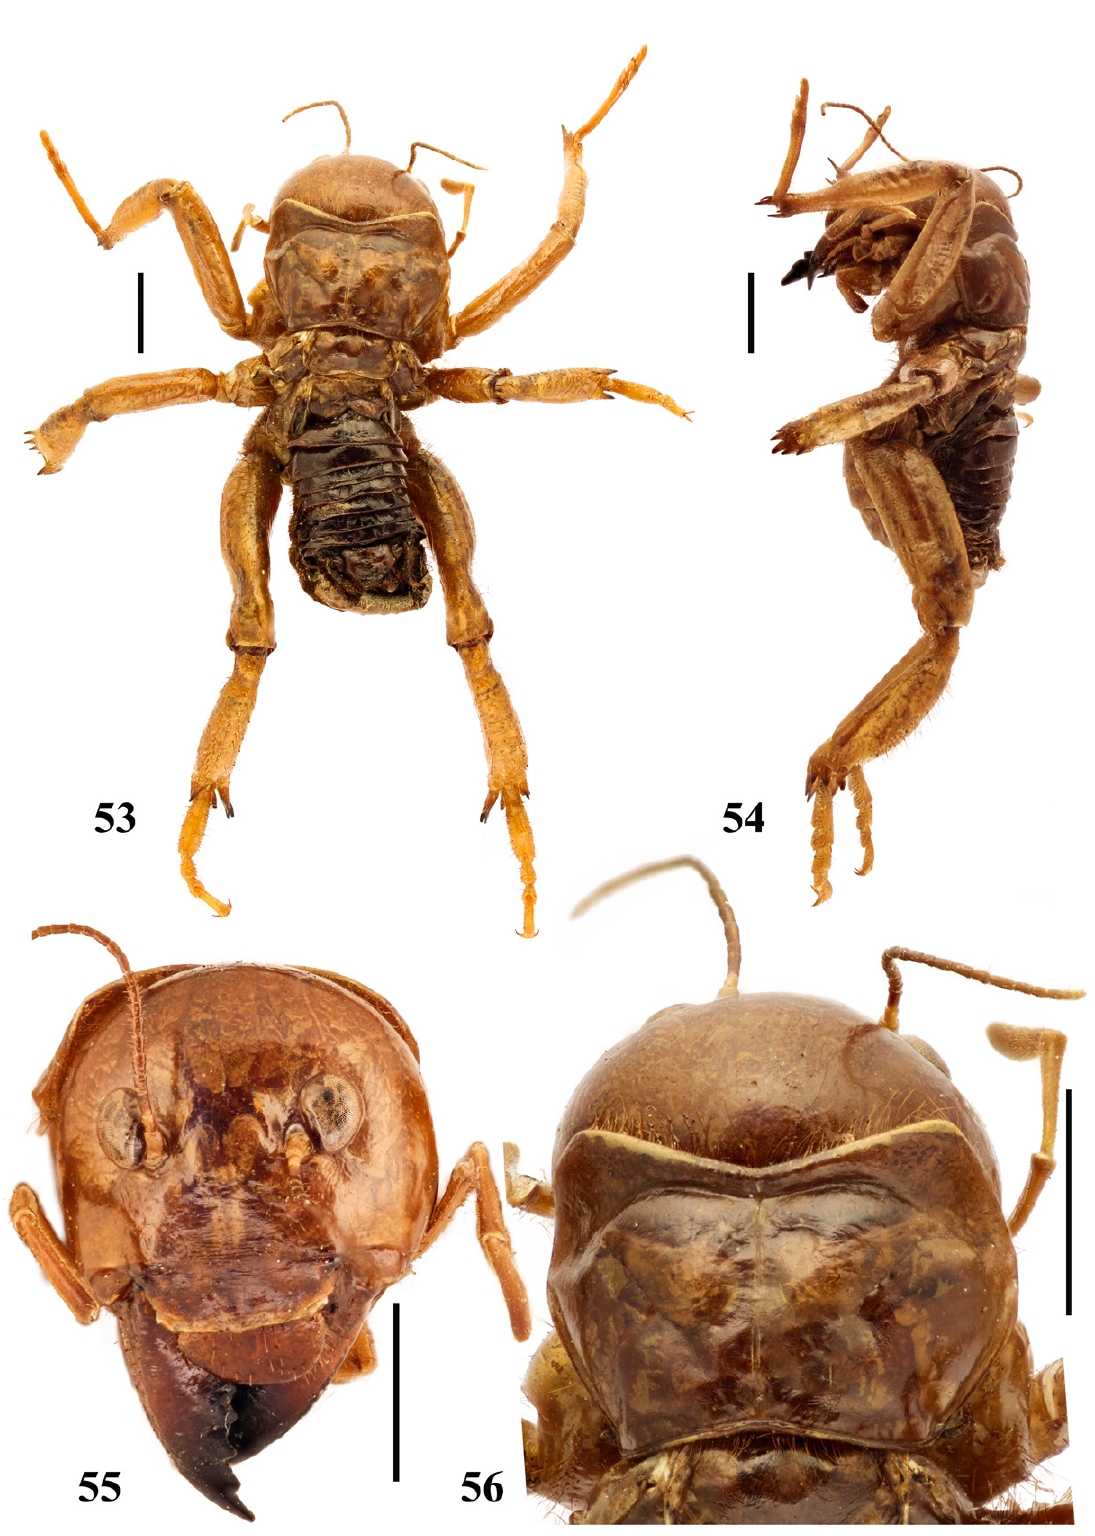
Figs 53–56. Oryctopterus yeshwanthi sp. nov. Holotype, ♀ (UASB). 53 . Dorsal habitus. 54 . Lateral habitus. 55 . Head, frontal view. 56 . Head and pronotum in dorsal view. Scale bars = 5